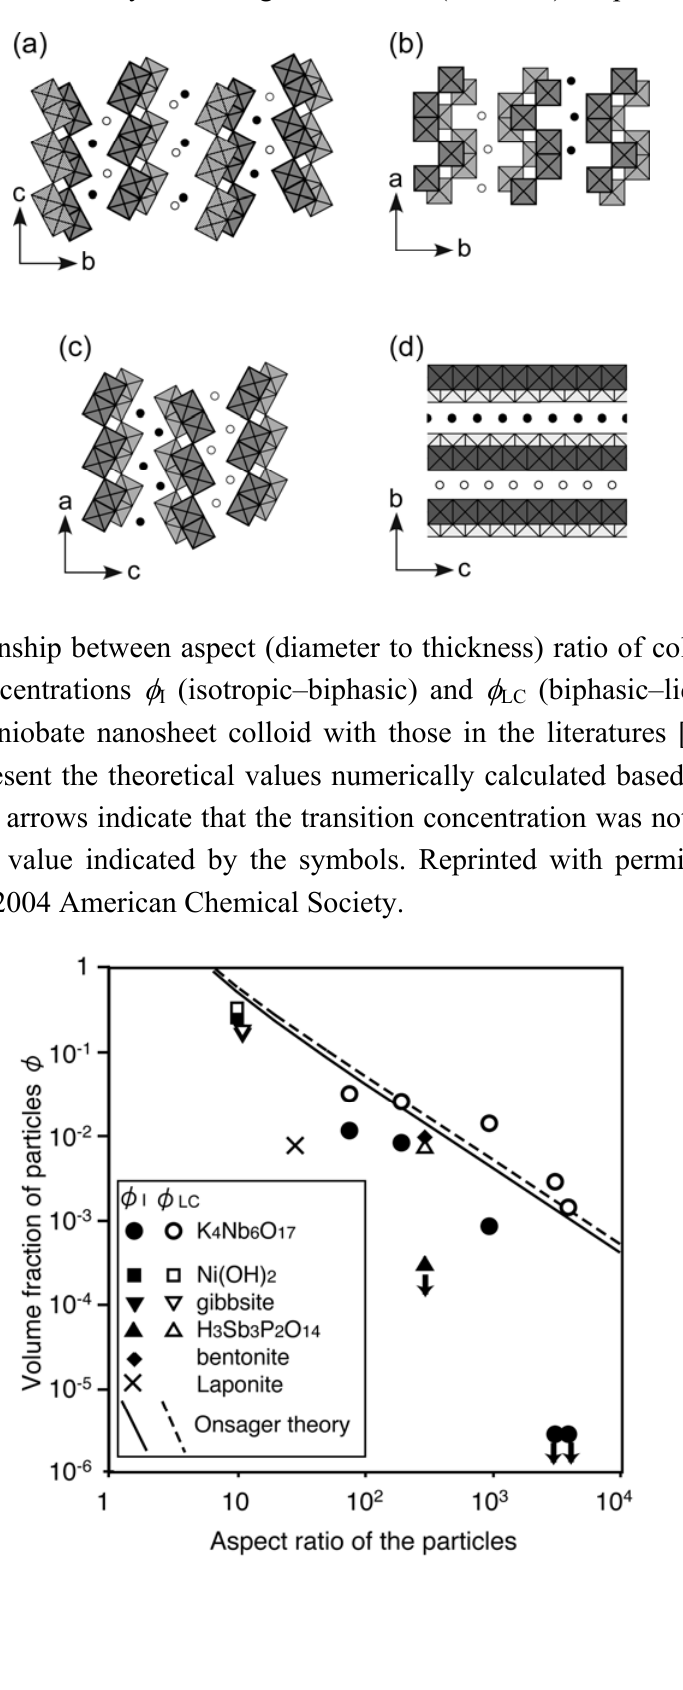
Nb O , (b) HNb O , (c) 4 6 17 3 8 or TiO octahedra that 6 6